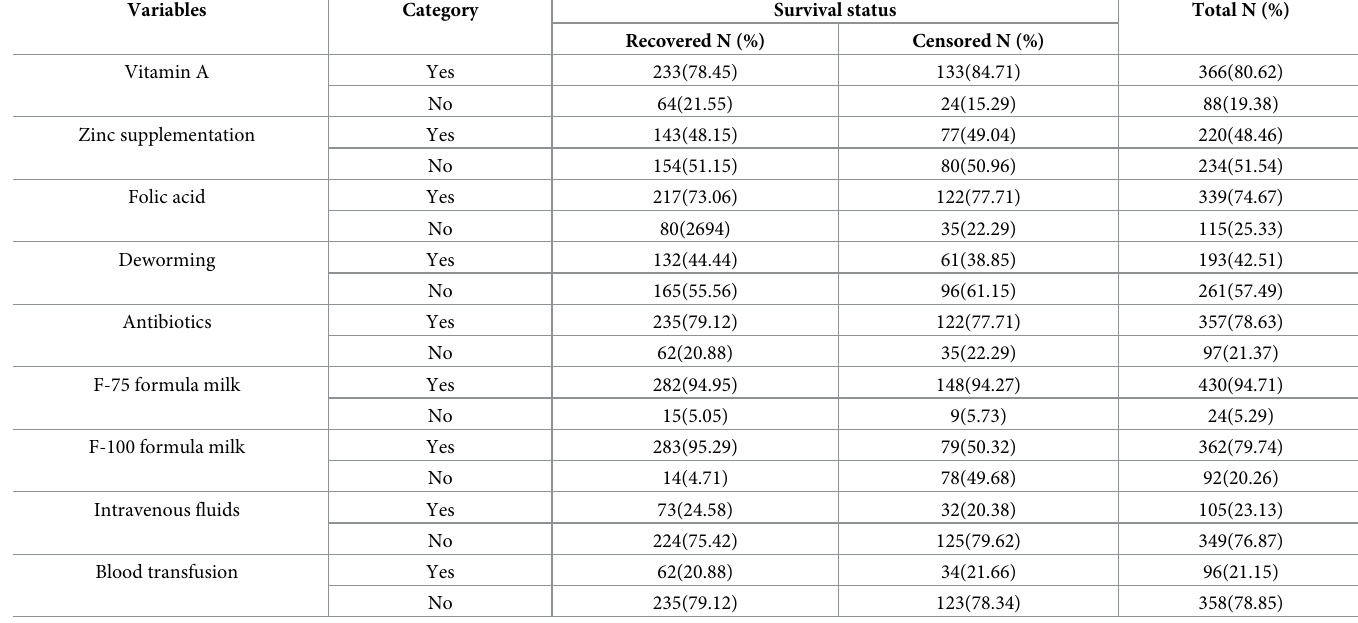
Table 2. Medication distribution for 6–59 months old children with SAM at Asosa general hospital, North-west Ethiopia (n = 454)